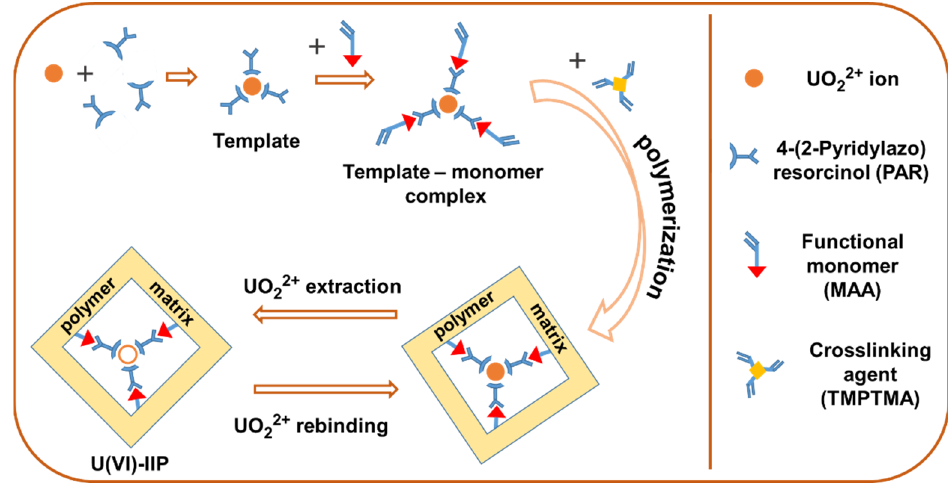
Figure 1. Scheme of the U(VI)-IIP